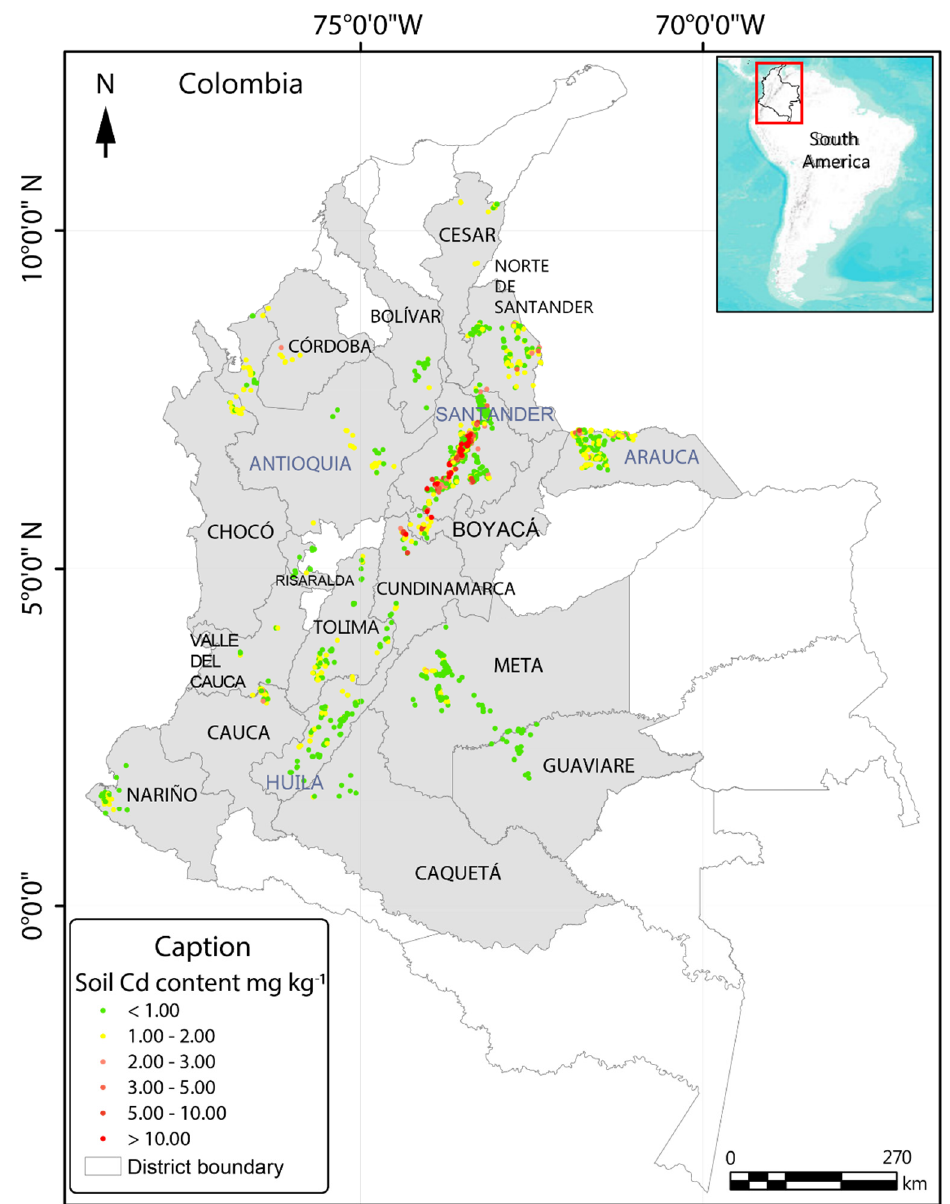
Figure 1. Distribution of pseudototal Cd in the soil of 1,837 cacao-growing farms in Colombia. Grey districts correspond to the existing data. White districts belong to areas where no pseudototal Cd data was found.